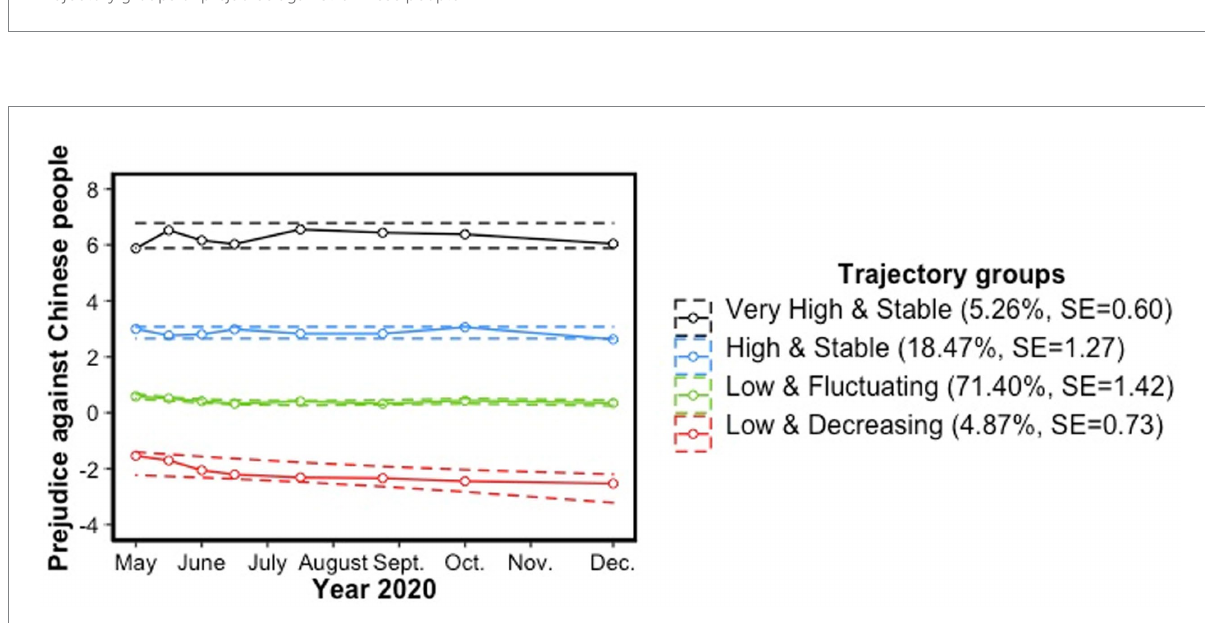
FIGURE 2 Trajectory groups of prejudice against Chinese people with confidence